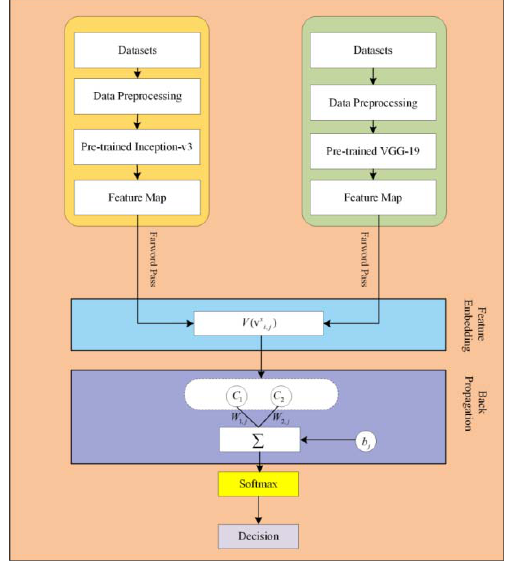
Figure 2. The block diagram of the proposed approach.